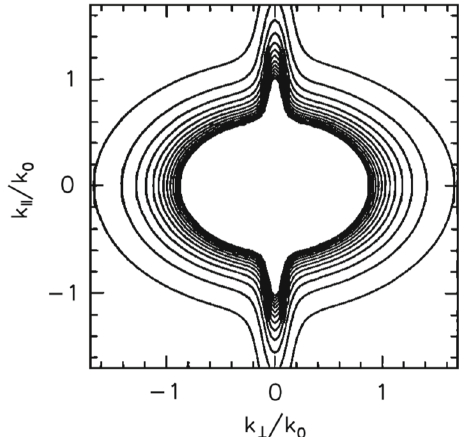
Fig. 16 Contours of the energy spectrum in the wavevector domain estimated from the single spacecraft measurements in the solar wind. Image reproduced with permission from Carbone et al. (1995), copyright by